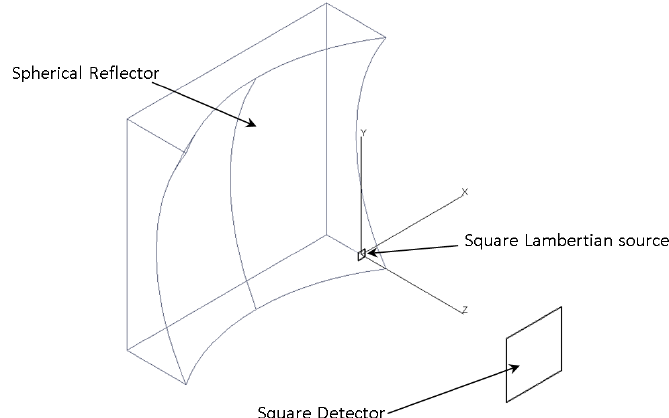
Figure 7. Sketch of the analyzed 3D reflective optical systems.